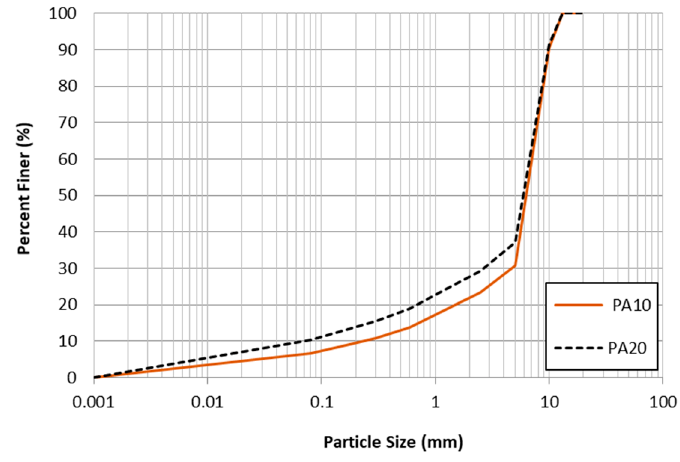
Figure 1. Aggregate gradations of PA10 and PA20.